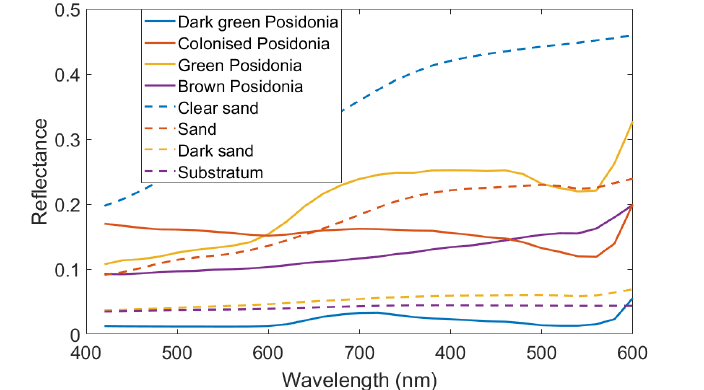
Figure 6. Various spectra representative of sand, Posidonia and substratum, collected in the studied